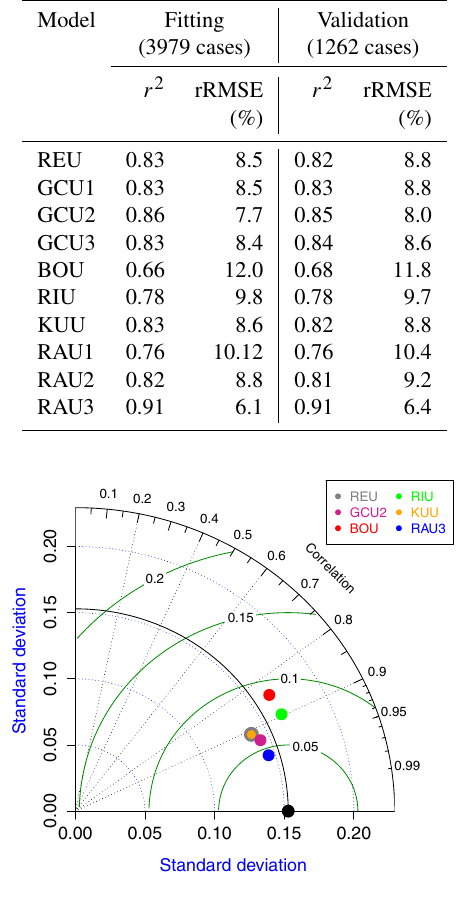
Figure 2. Taylor diagram showing the performance of the models proposed to estimate the diffuse fraction, as compared to experi- mental measurements. This diagram summarizes different aspects of the performance of a model such as the centered root-mean- square error (green lines), the correlation, and the standard devia- tion with respect to the reference data set (black